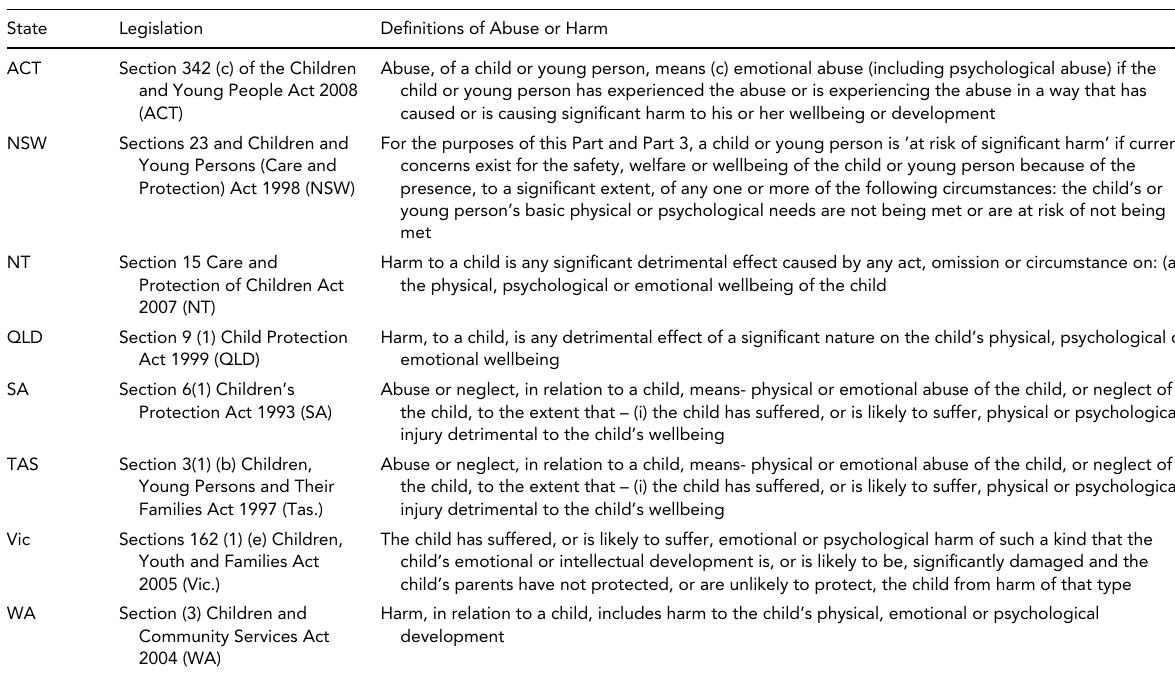
The Definitions of Abuse or Harm in State and Territory Legislations in